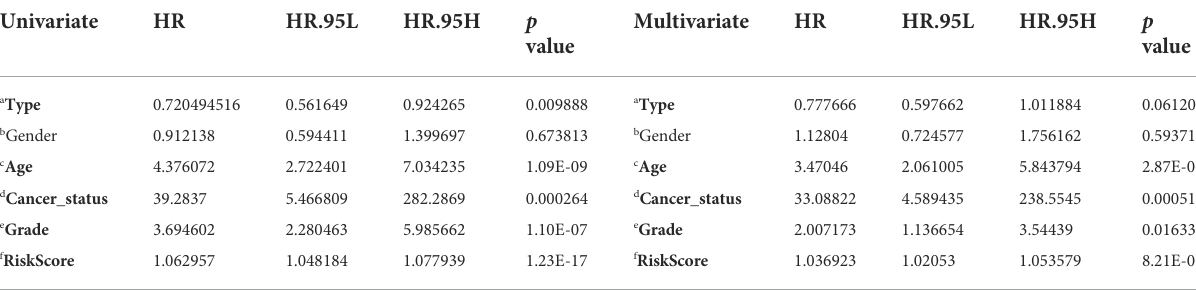
a Type: Astrocytoma, Oligoastrocytoma, Oligodendroglioma. b Gender: Female, Male. c Age: ≤ 41, > 41. d Cancer_status: Tumor free, With